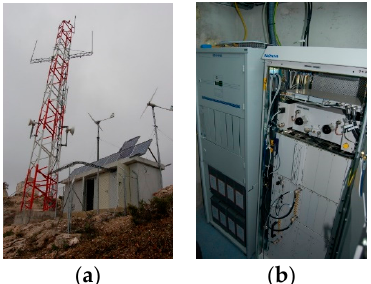
Figure 1. ( a ) Telecommunication tower with antennas and stand and ( b ) TETRA base station equipment.